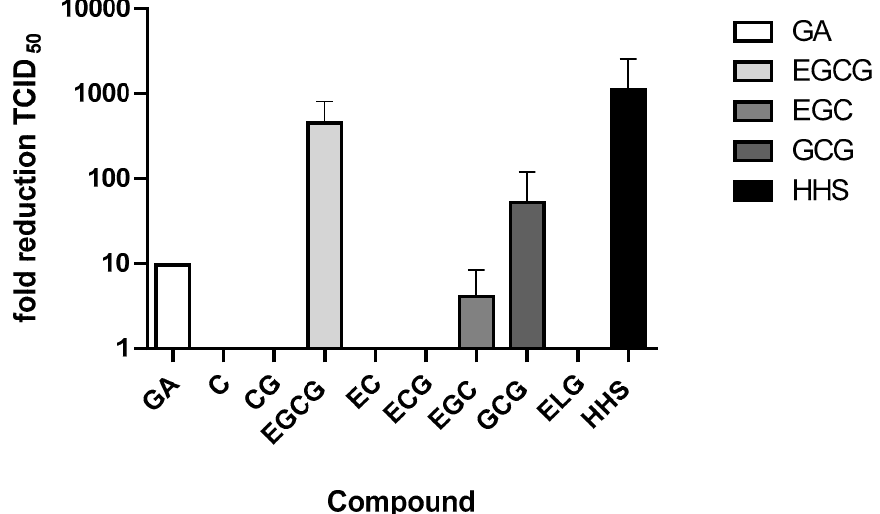
Figure 2. Effect of treatment of Vero cells with the respective substances compound (50 µM) after infection of the cells with SARS-CoV-2. Vero cells were preincubated for 45 min with either DMSO or the compound and infected with a SARS-CoV-2 stock. After five to seven days TCID50 dose was calculated. Values represent the average + half range of two